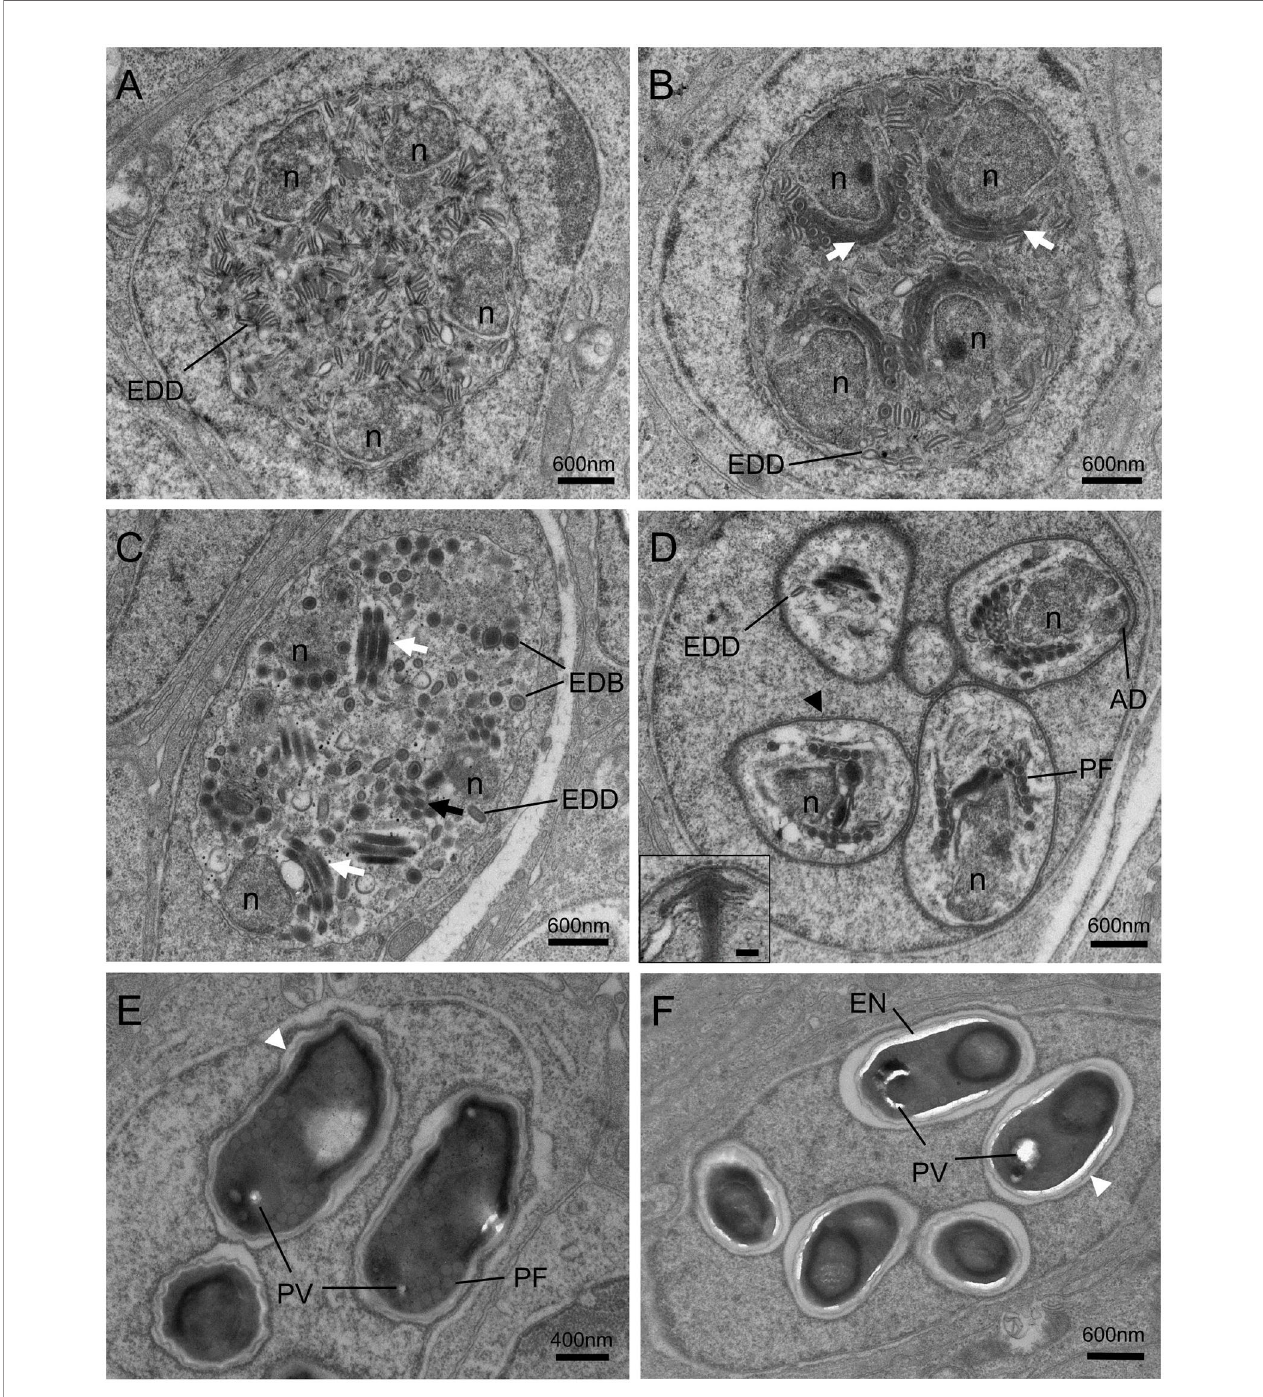
FIGURE 5 | Transmission electron micrographs of the sporogonic stages of Nucleospora hippocampi n. sp. in nuclei of intestinal epithelial cells of Hippocampus erectus . (A) The sporogonial plasmodium contains numerous electron-dense discs (EDD) and four nuclei (n) distributed close to the inner edge of the cytomembrane. (B) Multinucleate sporogonial plasmodium contains four sets of the primordial polar tube (white arrows). EDD is associated with primordial polar tube formation. (C) Late-stage sporogonial plasmodium with increased precursors of the polar tube (white arrows) and reduced EDD. The EDD transform into rounded electron- dense bodies (EDB), then the EDB coalesce into primordial turns of the polar tube (black arrow). (D) The sporoblasts ( fi ve are visible) develop in direct contact with the host nucleoplasm. The sporoblasts showing parasite nucleus (n), coiled polar tube with 6 – 7 turns (PF), and thickened plasmalemma (arrowhead). Insert showing the magni fi cation of anchoring disk (AD). Insert scale bar = 0.1 m m. (E) Late immature spore with preformed winding spore wall (white arrowhead), posterior vacuole (PV), and polar tube (PF). (F) Mature spore with smooth spore wall (white arrowhead) and thickening electron lucent endospore